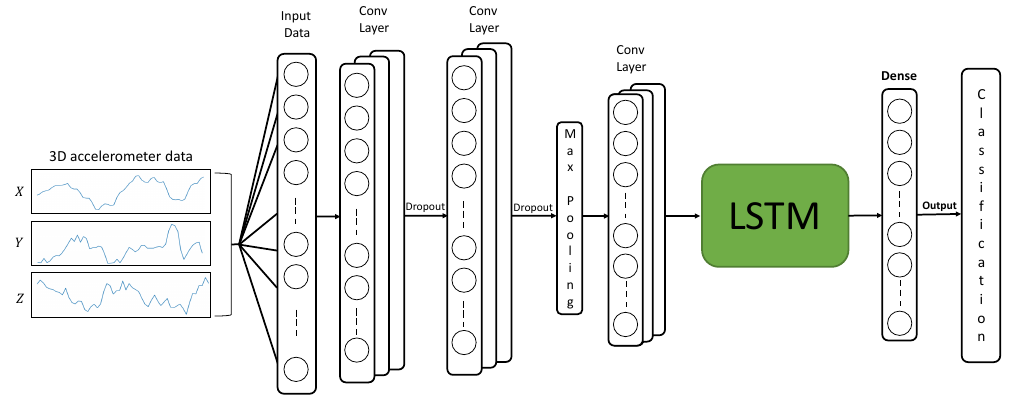
Figure 3. CNN-LSTM architecture.